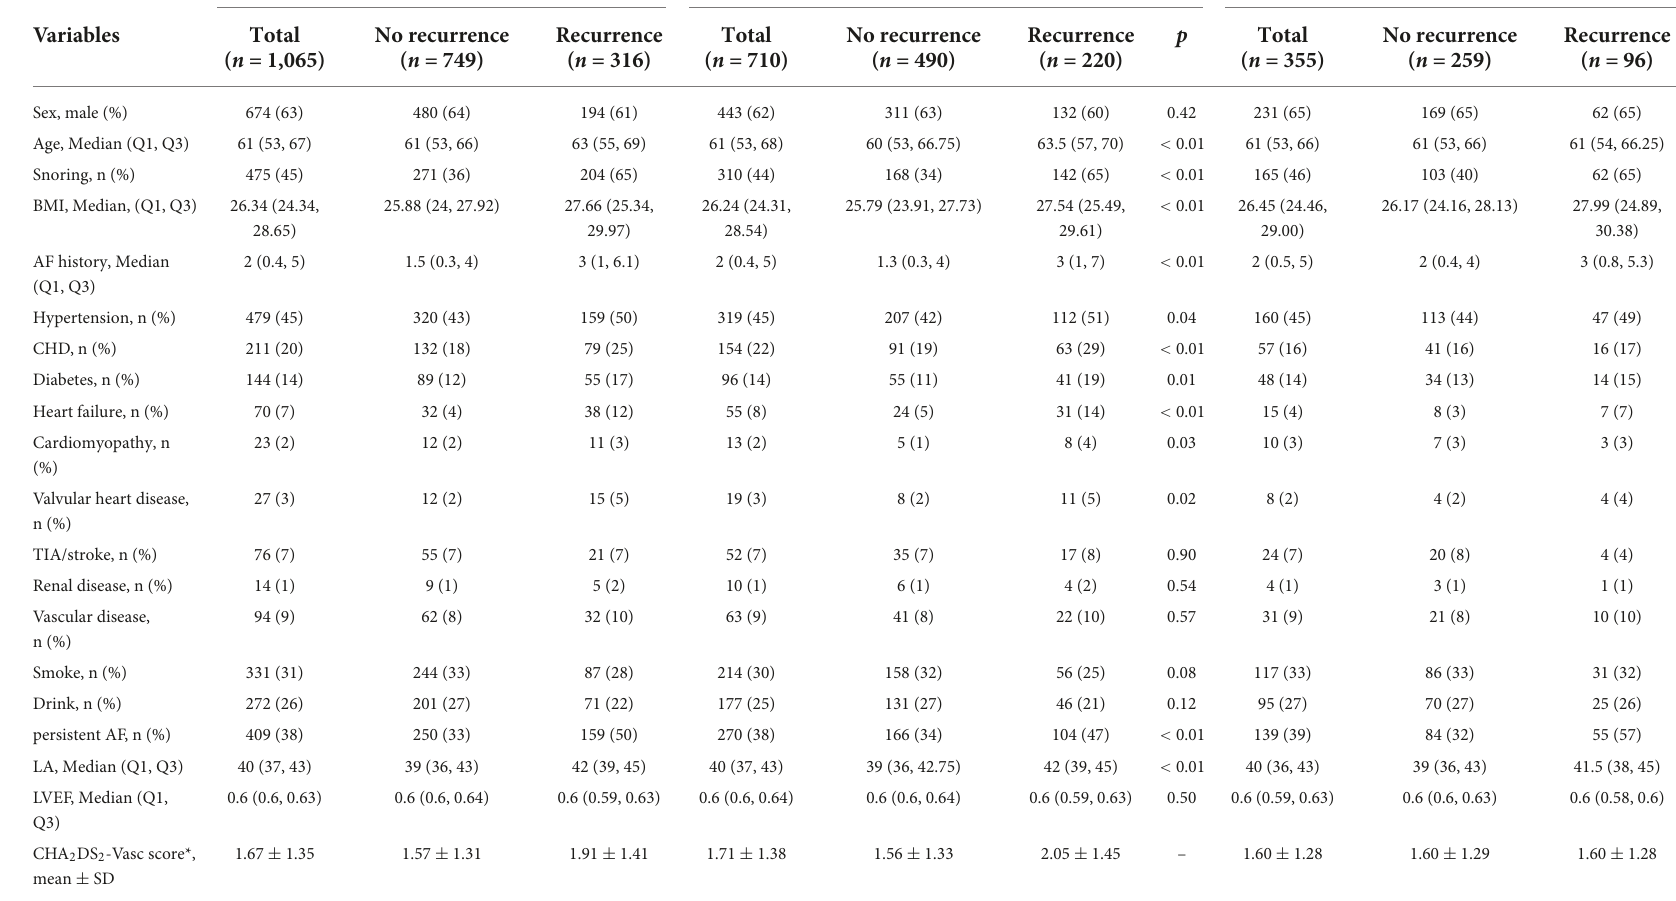
TABLE 1 Baseline characteristics of all